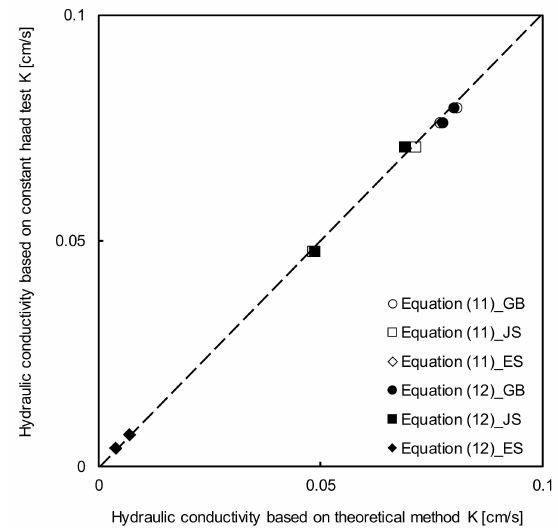
Figure 11. Comparison of hydraulic conductivity obtained by the theoretical methods and constant head